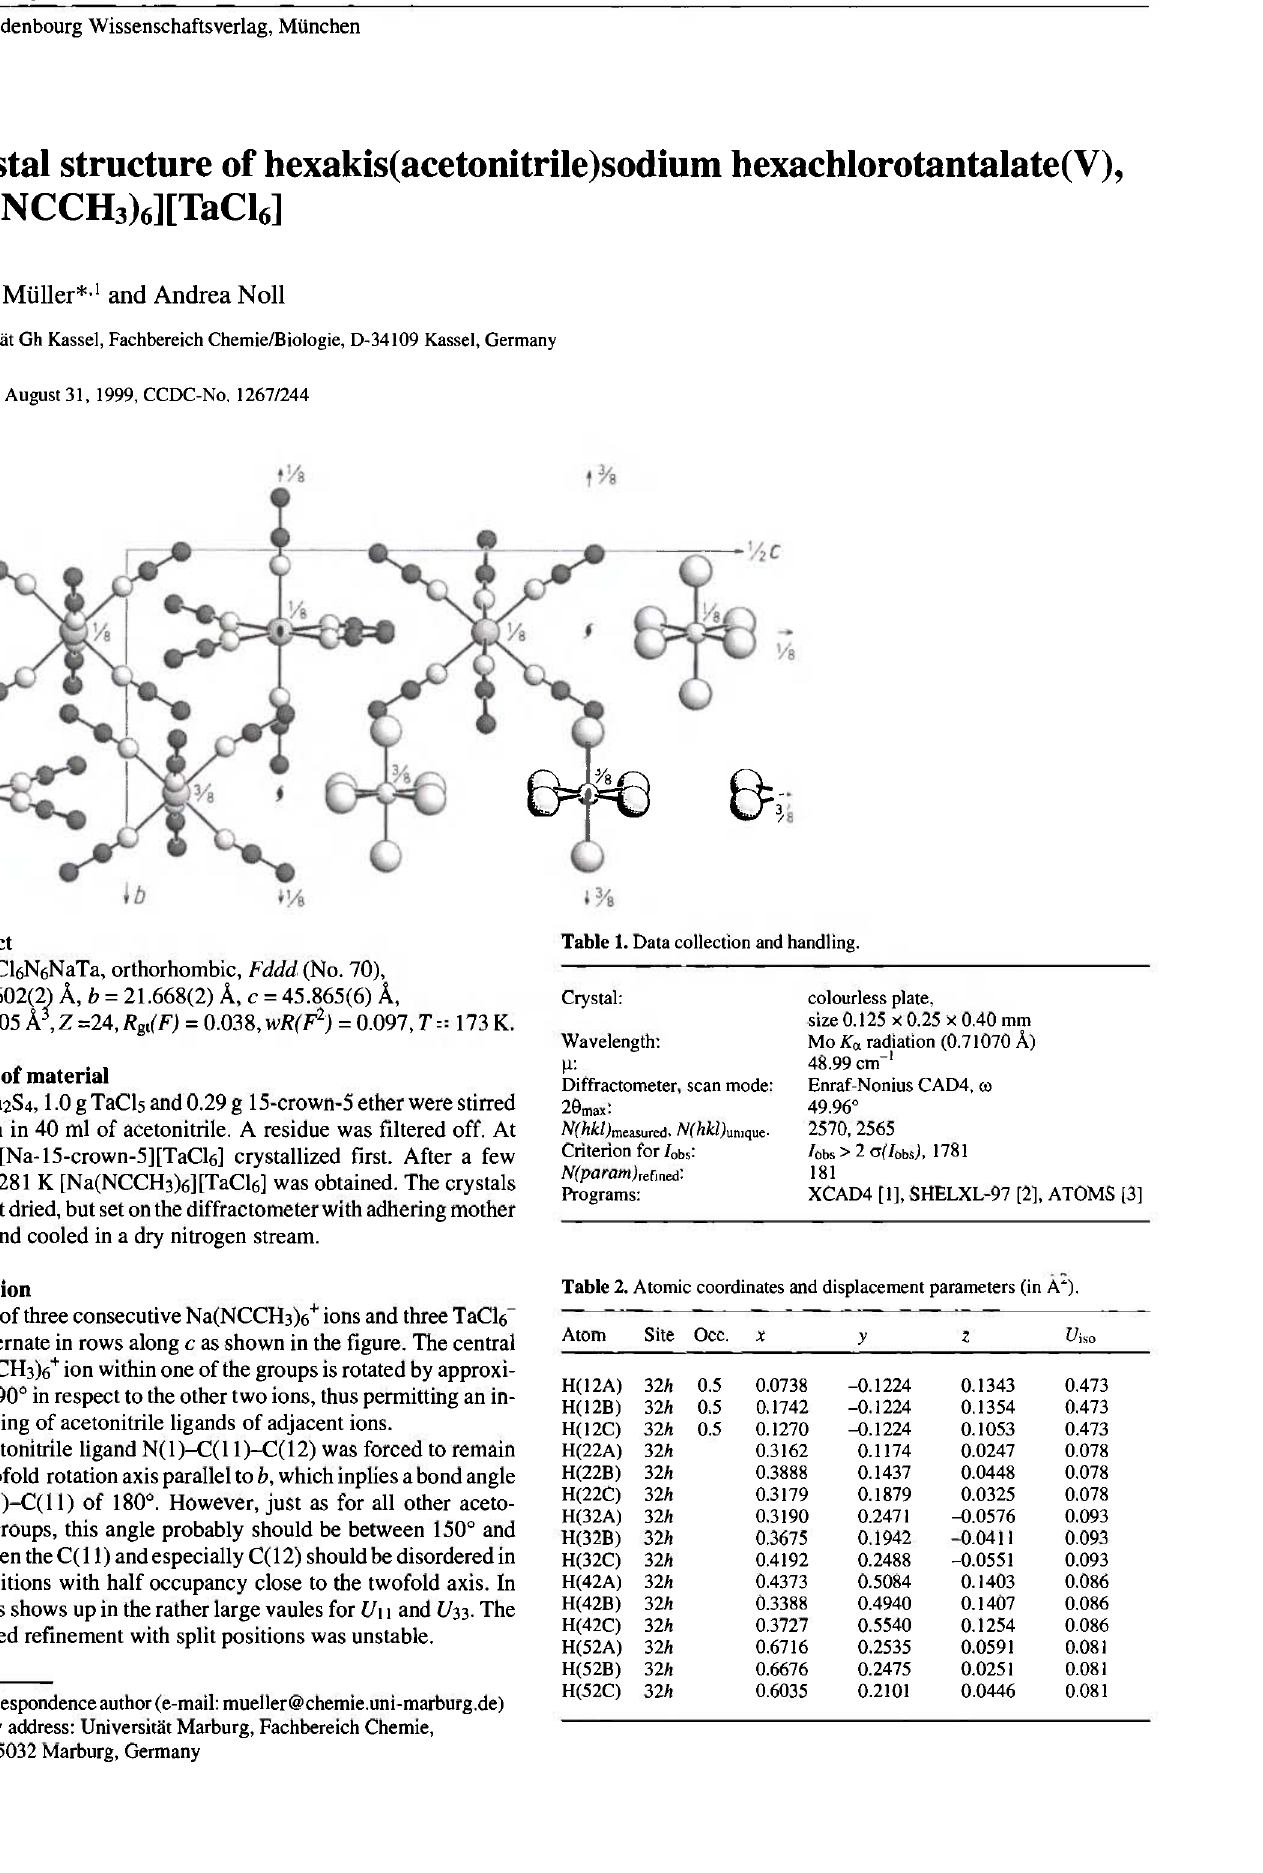
Table 2. Atomic coordinates and displacement parameters (in A